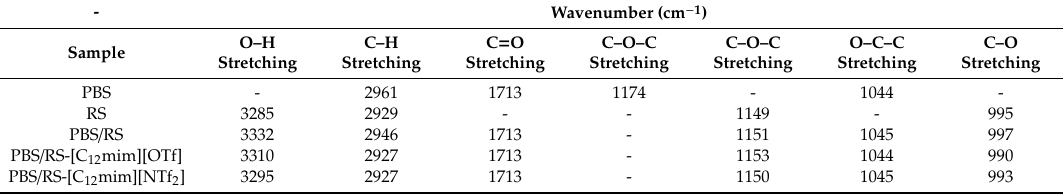
Table 4. FTIR bands of the PBS, RS and PBS / RS blends without and with containing ILbS.